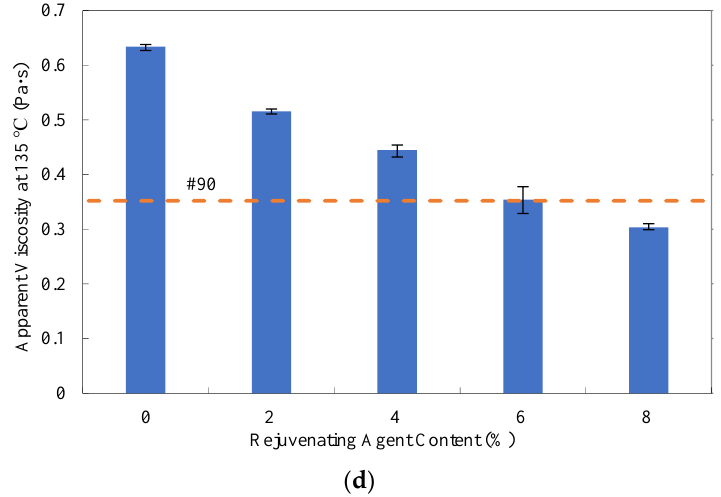
Figure 4. Basic properties of rejuvenated asphalt binders at different rejuvenating agent contents: ( a ) penetration; ( b ) softening point; ( c ) ductility; ( d ) apparent viscosity.